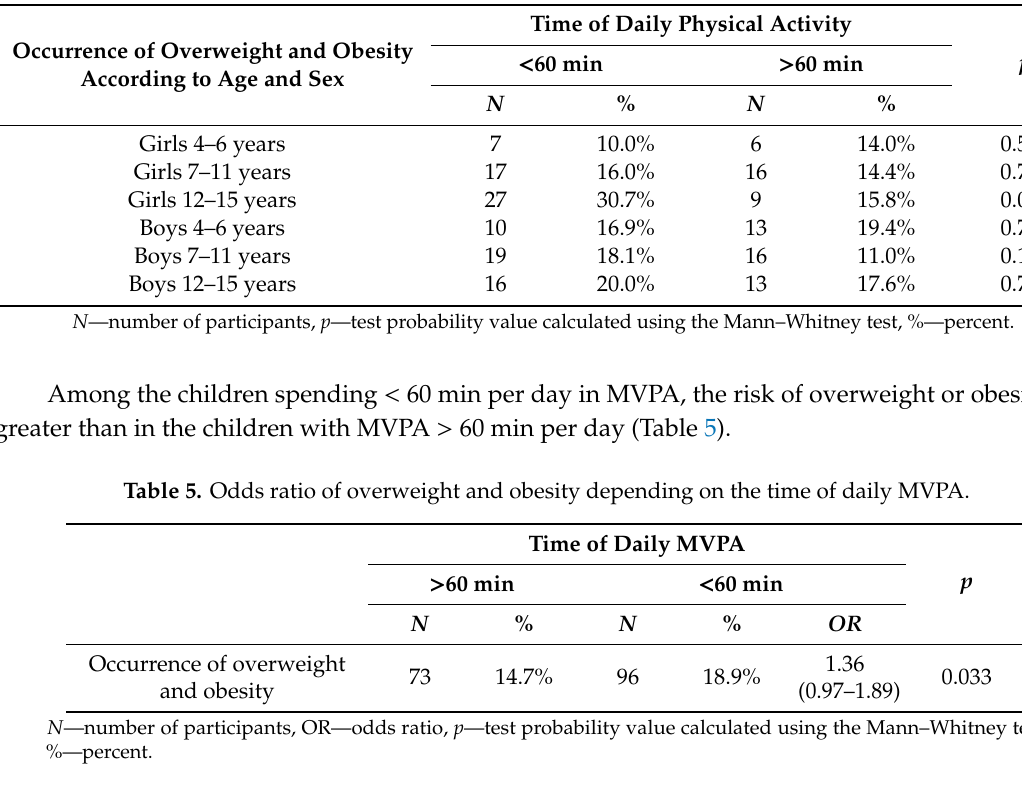
Table 4. The relationship between the occurrence of overweight and obesity and the recommended time of physical activity, taking into account the sex and age of the participants.